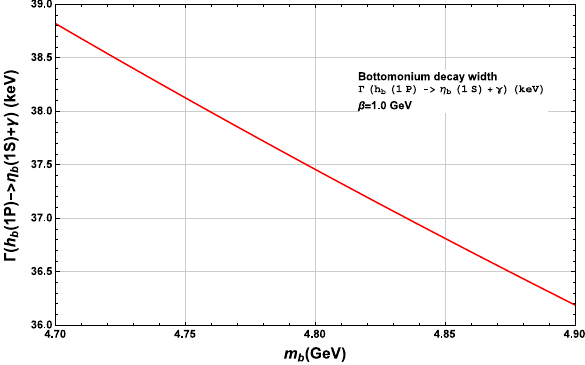
Fig. 5 Decay width for h b ( 1 P ) → η b ( 1 S ) + γ (keV) as a function of = 1 . 0 m b in the LFQM, with β h b ( 1 P )(η b ( 1 S ))